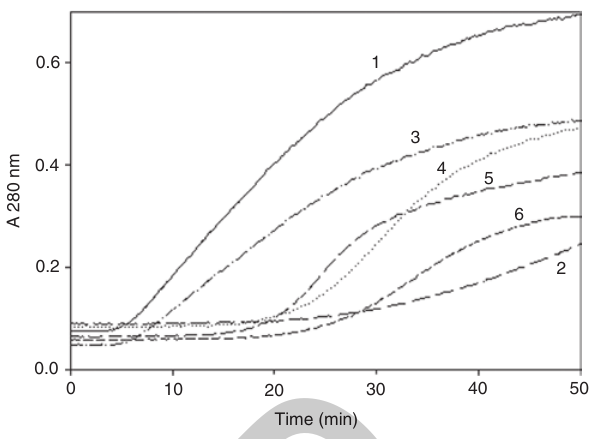
Figure 3: Representative sub-unit profile and protein cross-linking of the soluble fraction of dementia peptide-injected lenses. Lane 1: markers, lane 2: DMSO, lane 3: ADan-red, lane 4: ADan-oxi, lane 5: A β 1-40, and lane 6: A β 1-42. The arrow indicates cross-linked proteins in the peptide-injected lens under reducing conditions.